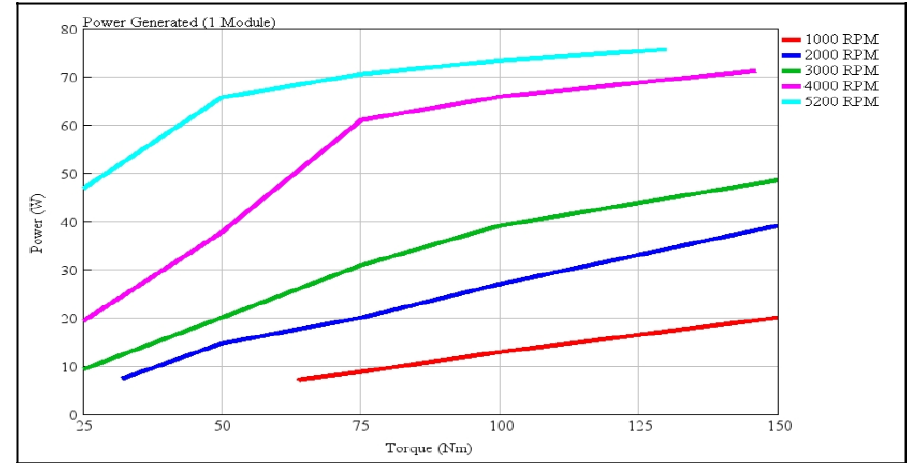
Figure 13. Power generated by 1 module (25 mm × 25 mm).